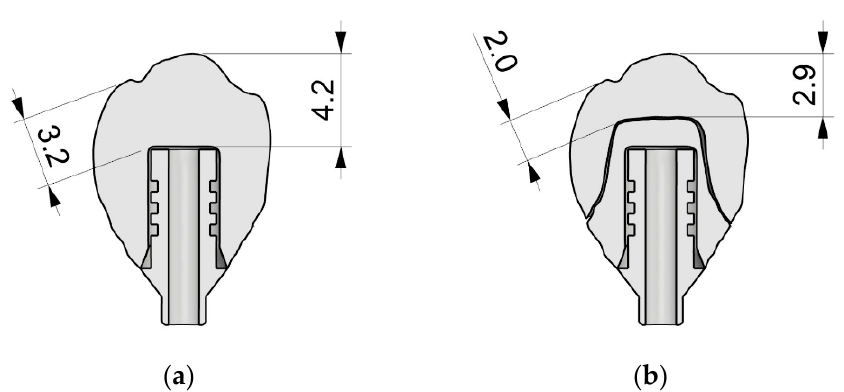
Figure 2 . Design sketches of the samples: ( a ) group 1 and ( b ) group 2.